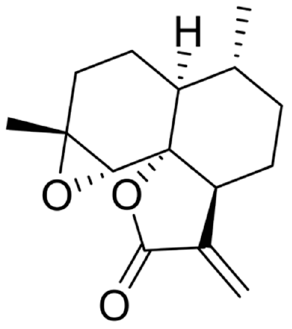
Figure 1. The chemical structure of AB. Drug-loaded microspheres are tiny spherical polymers that are made of